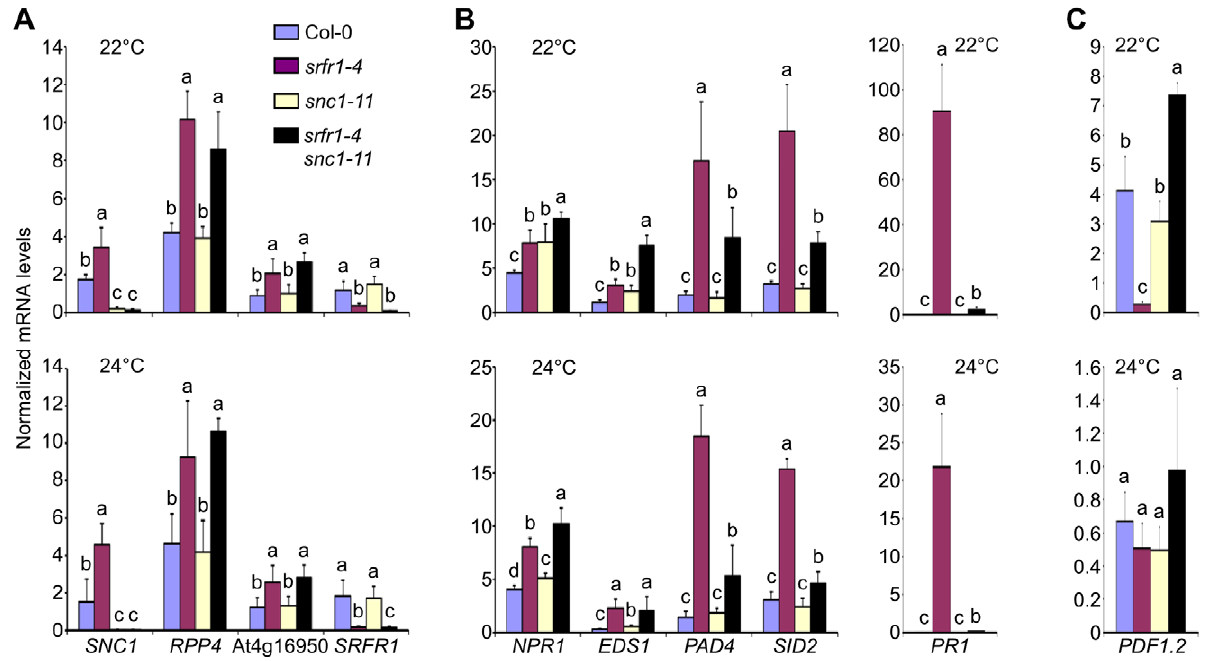
Figure 6. Transcript levels of defense-related genes are altered in srfr1-4 and srfr1-4snc1-11 . (A) Transcript levels of the co-regulated R genes SNC1 , RPP4 and At4g16950. (B) Transcript levels of NPR1 , EDS1 , PAD4 and SID2 (left) and PR1 (right). (C) Transcript levels of PDF1.2 . Transcript levels were measured by qPCR in Col-0 (blue bars), srfr1-4 (purple), snc1-11 (yellow) and srfr1-4 snc1-11 (black) at 22 u C (top) and 24 u C (bottom), and were normalized using SAND gene (At2g28390) mRNA levels as an internal control. Values represent averages from four biological replicates, and error bars denote standard deviation. Different letters denote significant differences between values calculated by Student’s t-test ( P , 0.05, n=4). This experiment was repeated once with similar results.